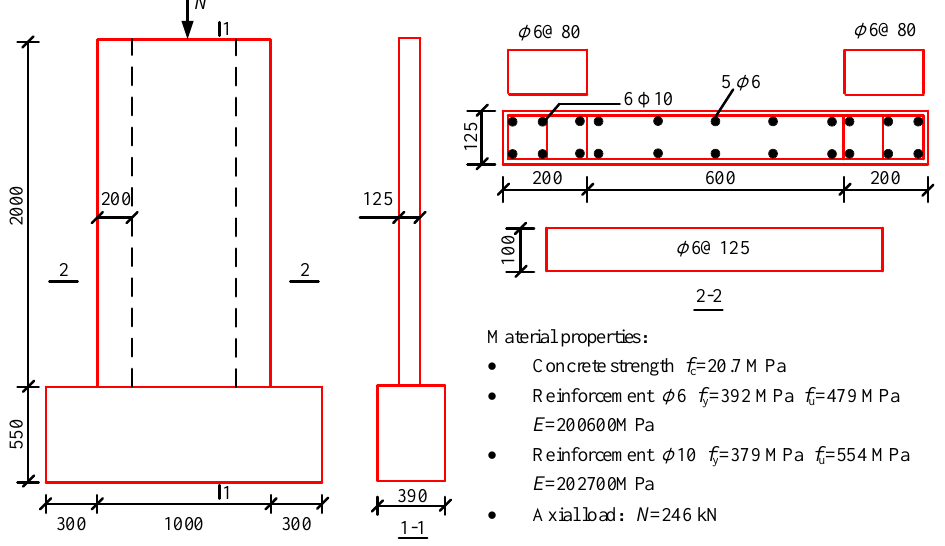
Figure 6. Details of the prototype specimen (unit: mm) [26].